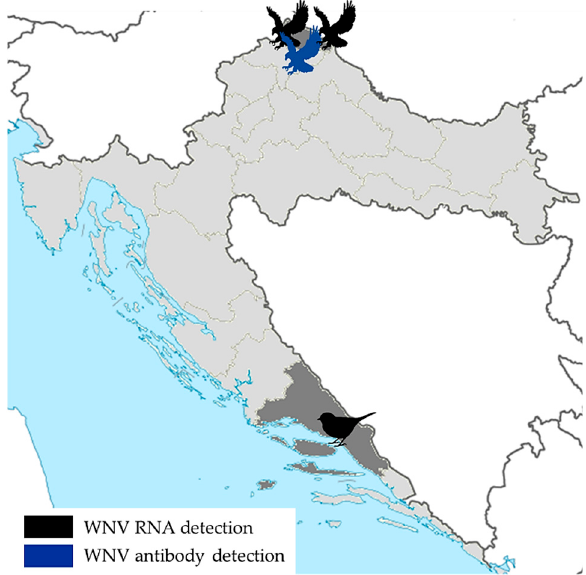
Figure 4. WNV infections in wild birds, 2018.